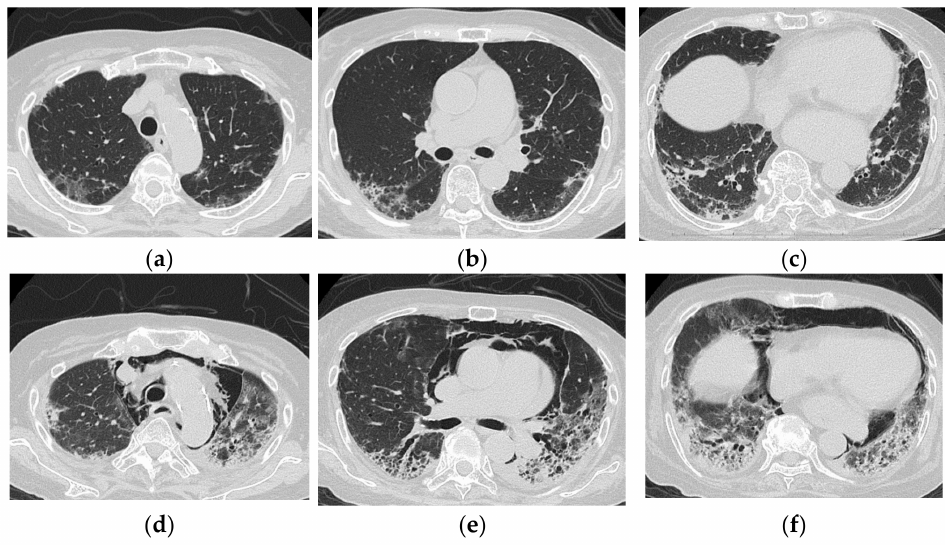
Figure 10. An 83-year-old woman with dermatomyositis related interstitial lung disease (anti-MDA5 Ab positive). At the time of initial diagnosis ( a – c ), there was diffuse ground-glass opacification and consolidation with basal and subpleural predominance. Subpleural parenchymal band-like opacity was also seen. One month later ( d – f ), the lesion became more extensive, and increase of reticulation with traction bronchiectasis, lower volume loss was visible. Note the severe mediastinal